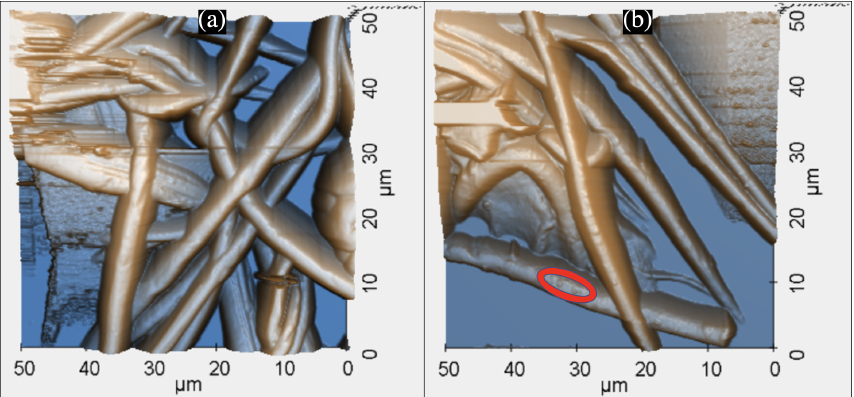
Figure 3. ( a ) 3D AFM Scanning Image of Pure PAN Nanofiber Disk ( b ) 3D AFM Scanning Image